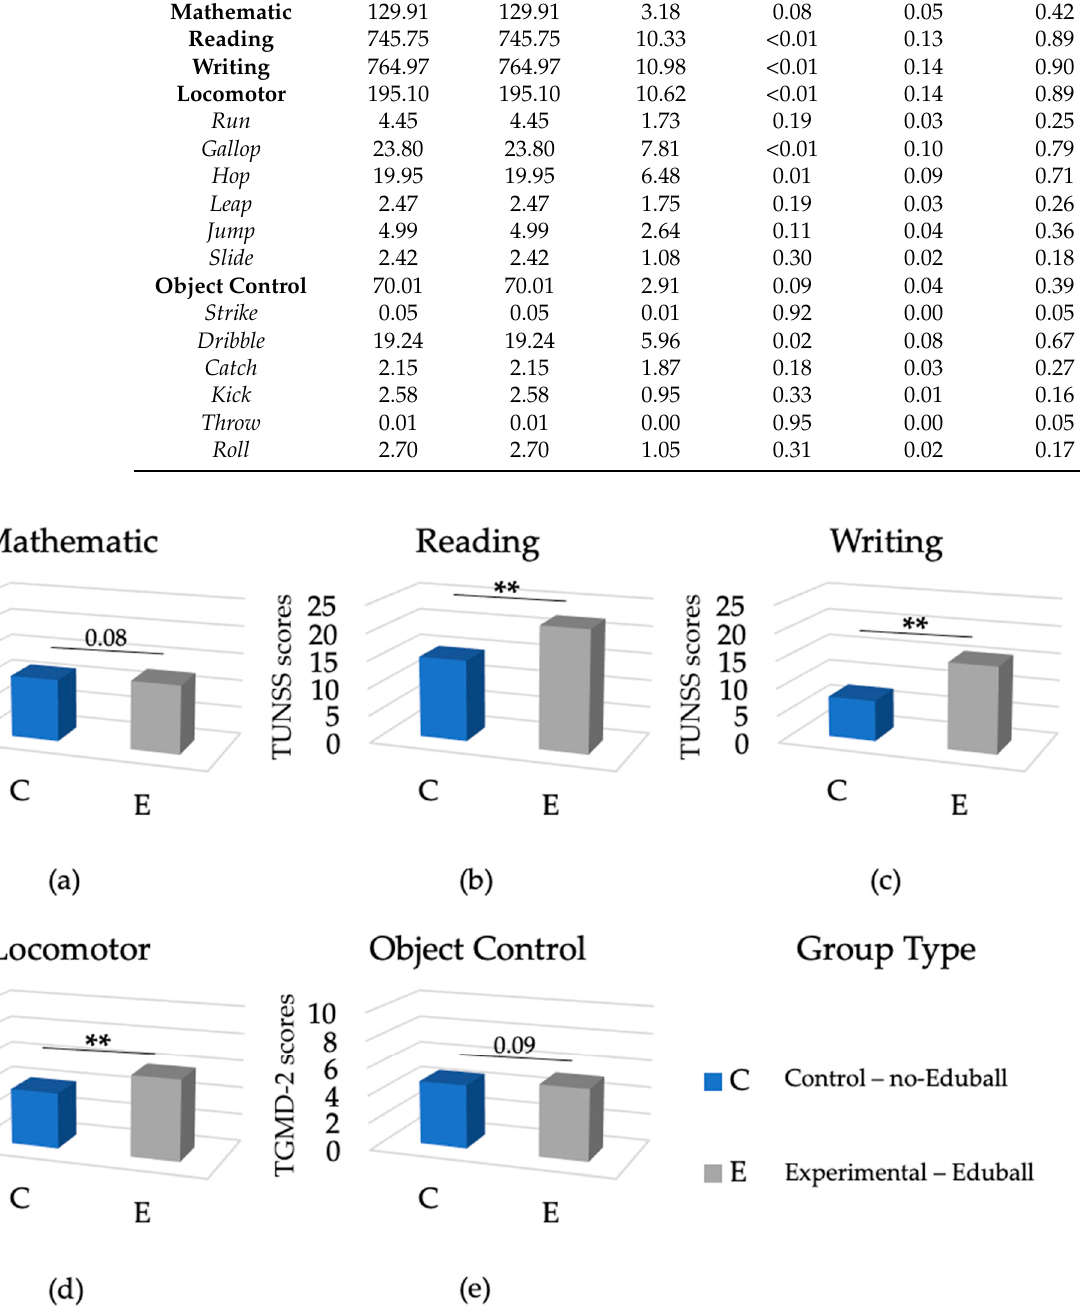
Figure 5. Results of the experiment, in terms of cognitive and motor skills, divided into two groups (no-Eduball vs. Eduball) and expressed as difference scores. ( a ) The results of the two groups in terms of mathematical skills; ( b ) the results of the two groups in terms of reading skills; ( c ) the results of the two groups in terms of writing skills; ( d ) the results of the two groups in terms of total locomotor skills; ( e ) the results of the two groups in terms of total object control skills. Asterisks (**) indicates significant p ( p < 0.01) and “0” the pre-test baseline.